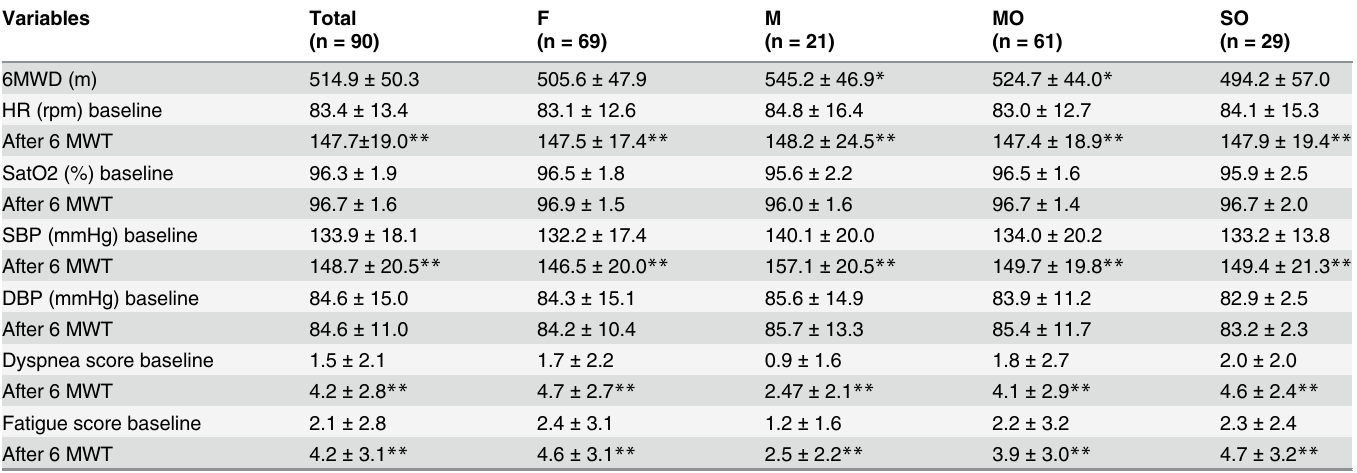
Table 3. 6MWT parameters of the study participants.